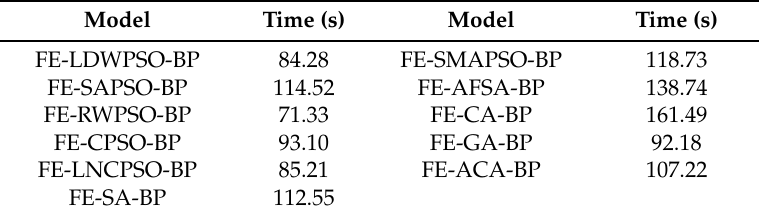
Table 9. Comparison of performance times for hybrid